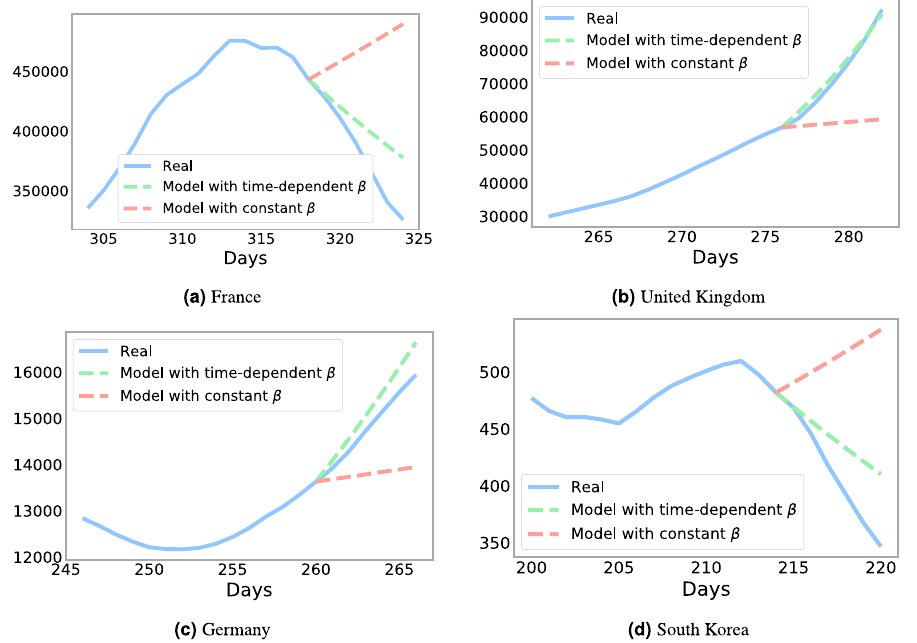
Figure 2. Comparison between the number of infected, I , from our data with a predicted I using the SIRD model using a constant β or a time-dependent β